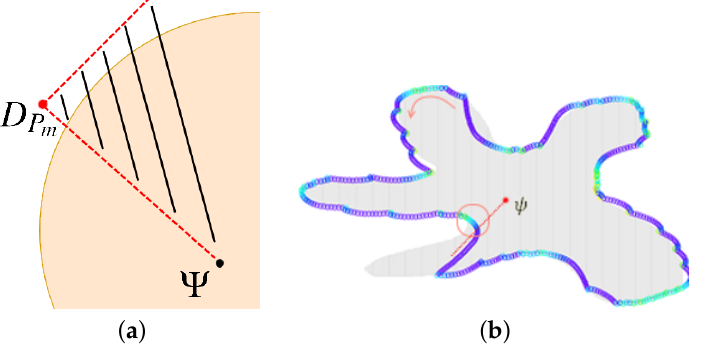
Figure 7. Tracking concave sections of the cloud boundary: ( a ) possible locations of target points, ( b ) sample motion trajectory of D P tracking a nonconvex cloud m